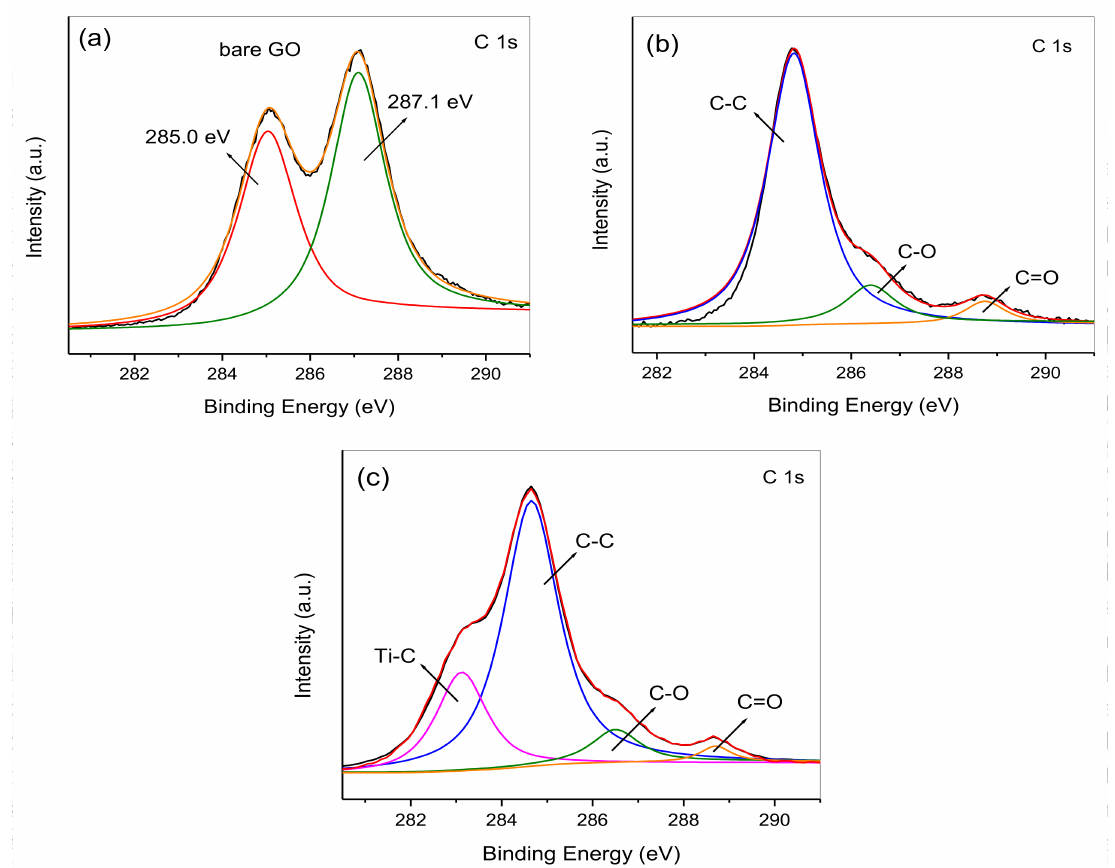
Figure 5. C 1s XPS spectra of ( a ) bare GO, ( b ) HTT/graphene-1.0%-mixed, and ( c ) HTT/graphene-1.0% chemically bonded nanocomposites.